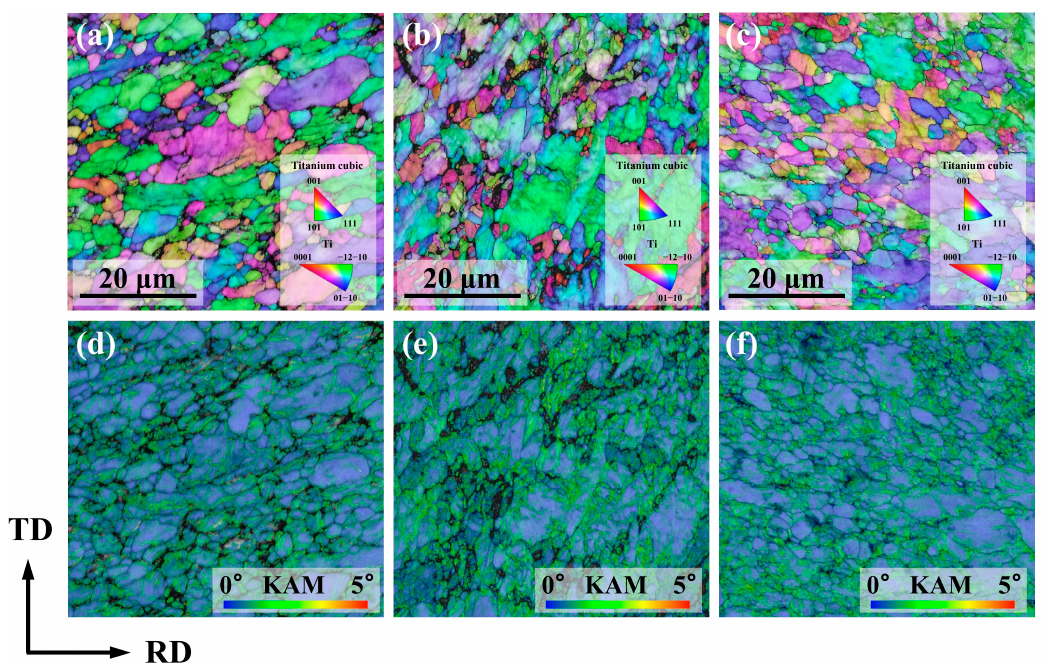
Figure 6. EBSD inverse pole figures (IPFs) of the ( a ) RD sample, ( b ) TD sample, and ( c ) DD sample at the fractured strains. ( d – f ) shows kernel average misorientation (KAM) maps of ( a – c ).